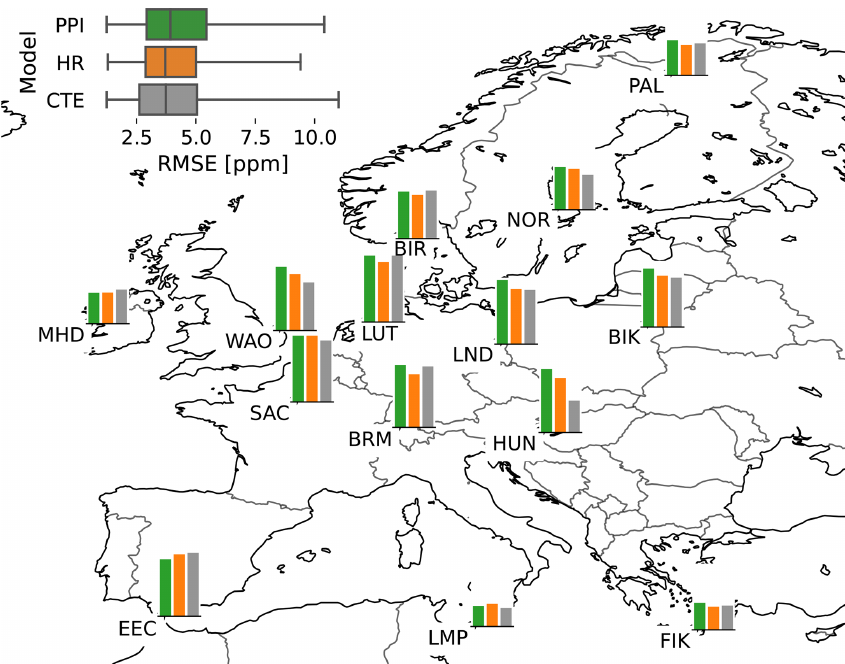
Figure 7. Root mean square error (RMSE) at selected stations in Europe. In the top left, a box plot of the monthly RMSE values is shown. PPI is the poor person’s inversion, HR is the CTE-HR flux (this work) and CTE2021 is the latest CarbonTracker Europe release. Note that all the bars have the same y axis, which has a maximum of